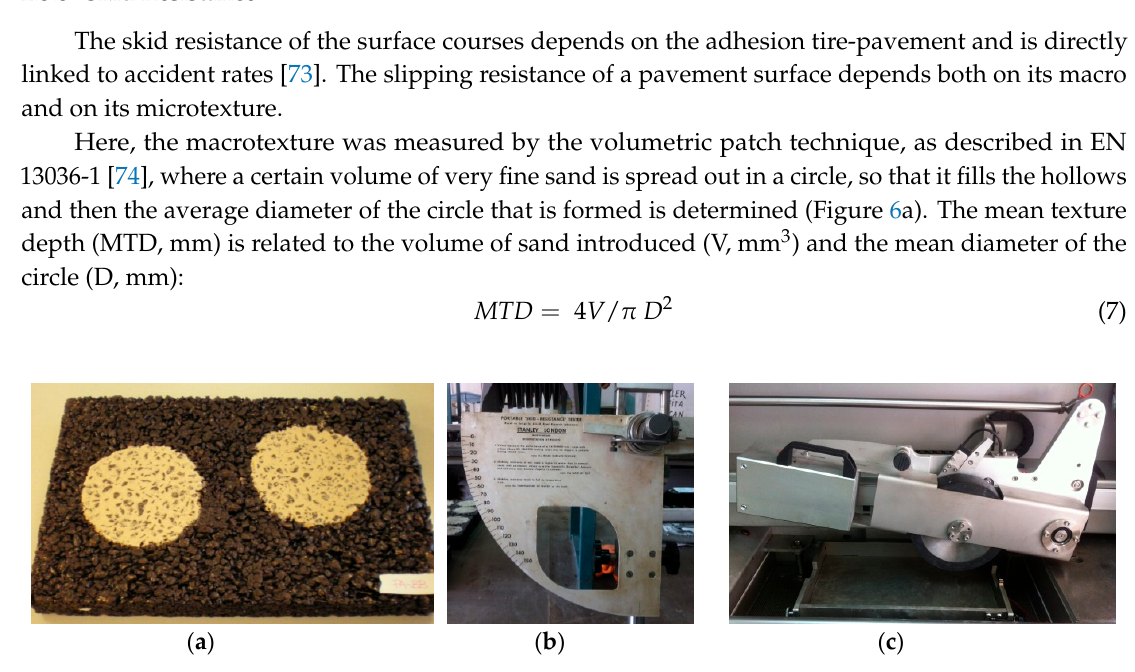
Figure 6. ( a ) Macrotexture; ( b ) British pendulum; ( c ) wheel tracking device.